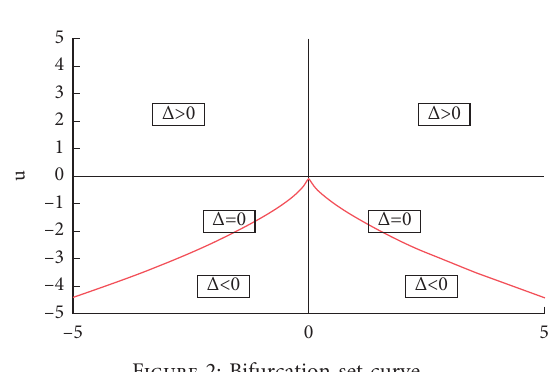
Figure 2: Bifurcation set